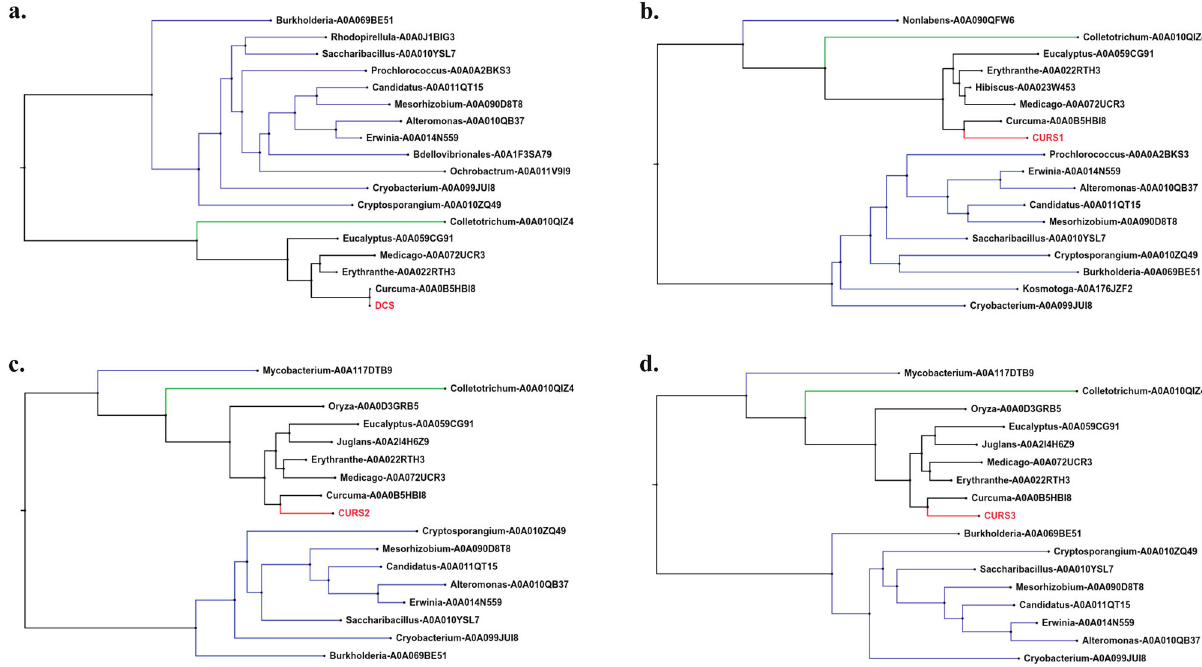
Fig. 4 Phylogenetic relationships of candidate enzymes of lower curcuminoid biosynthesis pathway in C. longa with their distant orthologous genes. a DCS gene. b CURS1 gene. c CURS2 gene. d CURS3 gene. Blue colored line denotes Bacterial orthologs, dark green colored line denotes fungal orthologs, black colored line denotes angiosperm orthologs, and red colored line denotes the genes of interest in C. longa